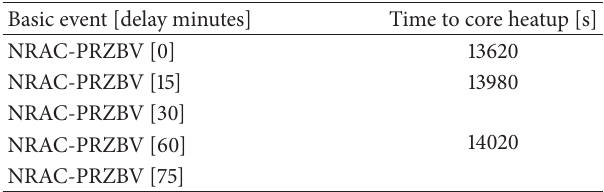
Table 4: Time to core heatup resulting from PRZ PORV stuck